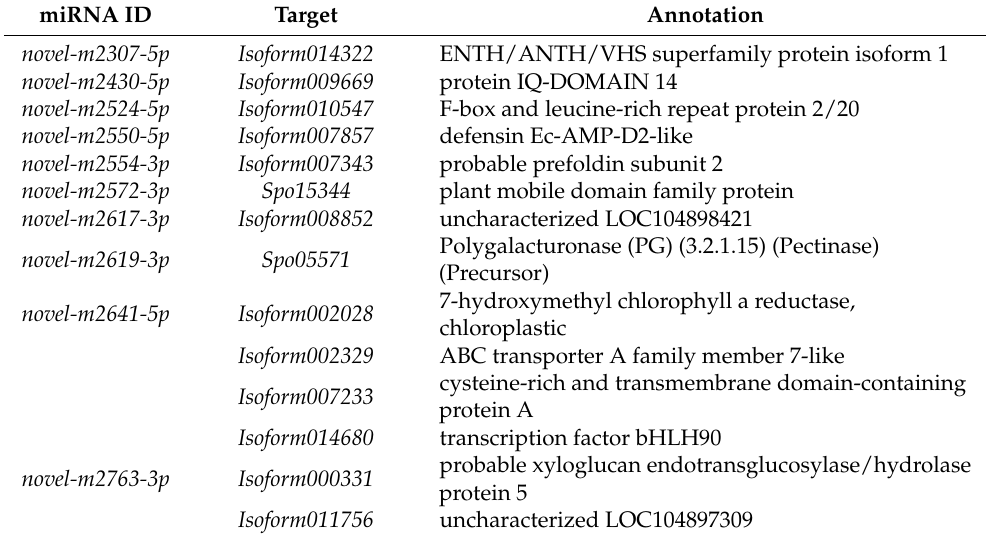
Table 4. DE miRNAs with targets between FNS and